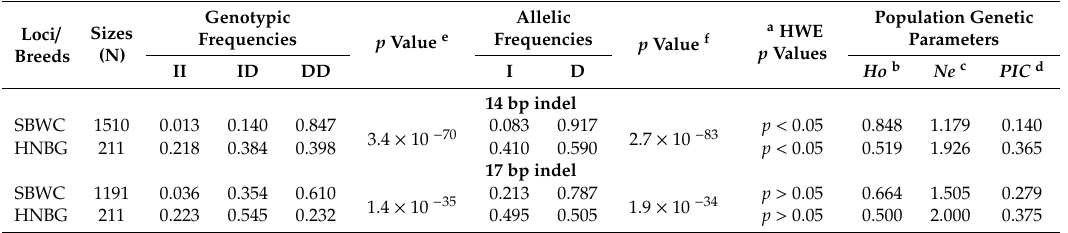
Table 2. Genotypic and allelic frequencies and population parameters of SPAG17 14 and 17 bp indels in goat breeds.